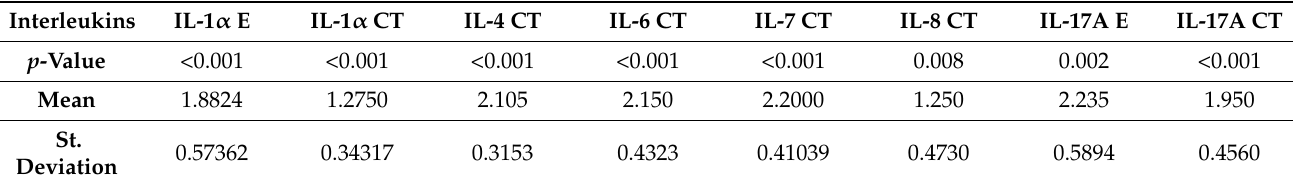
Table 3. Significant differences in interleukins of epithelium and connective tissue between patient and control tissue samples.